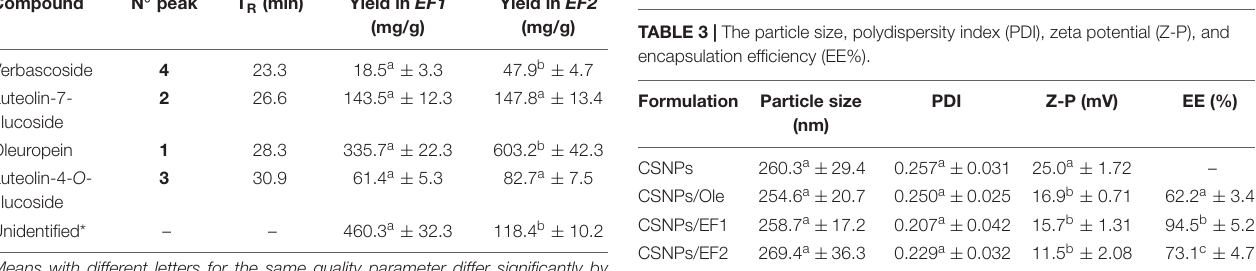
unidentified substances.